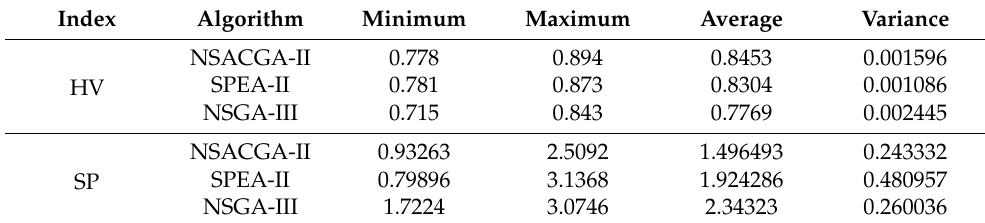
Table 10. HV and SP comparison results.